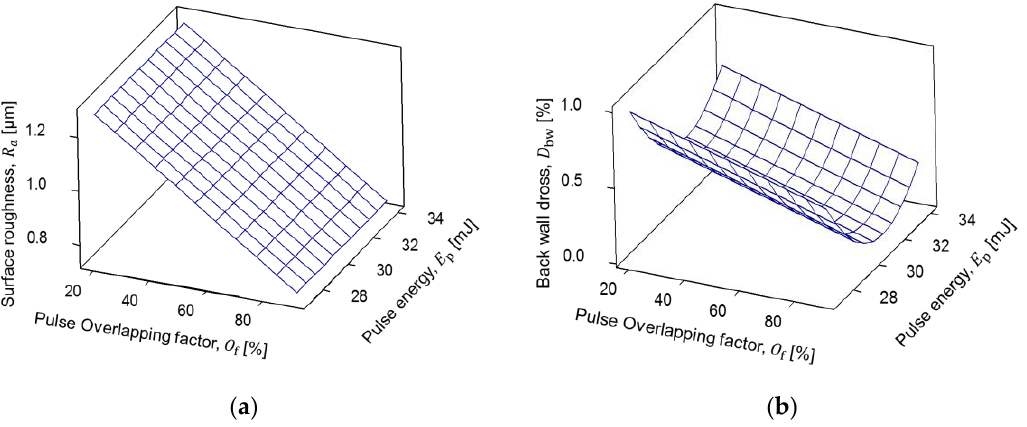
Figure 6. Results for Tube A (3 mm outside diameter and 0.22 mm wall thickness): ( a ) average surface roughness response; ( b ) back-wall dross response.